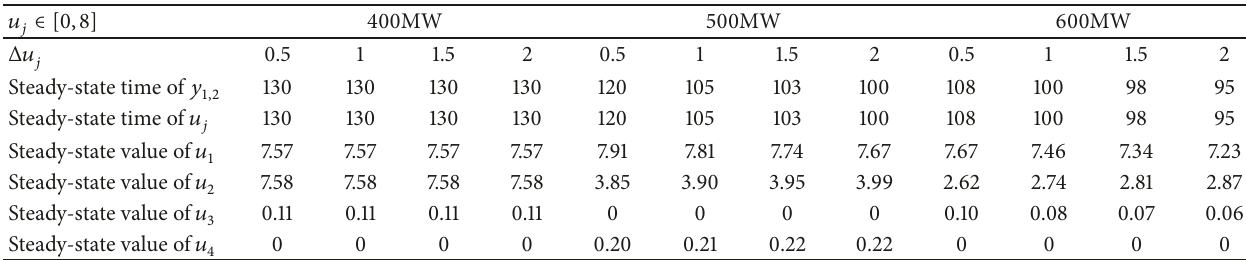
Table 7: Steady-state values of 𝑢 𝑗 when 𝑢 𝑗 ∈ [0,8]